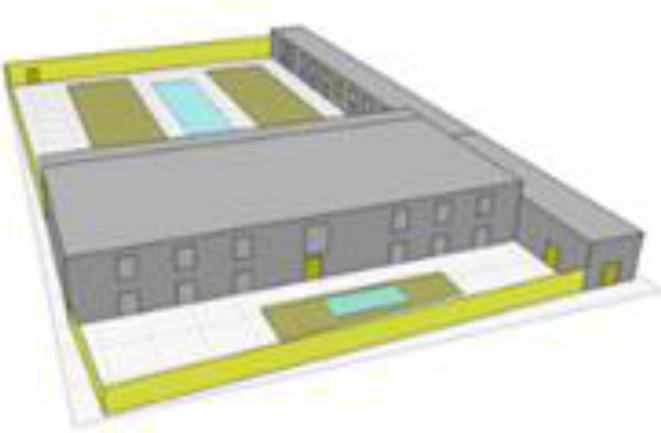
Figure 14 Geometry of house No. 3; north facing façade